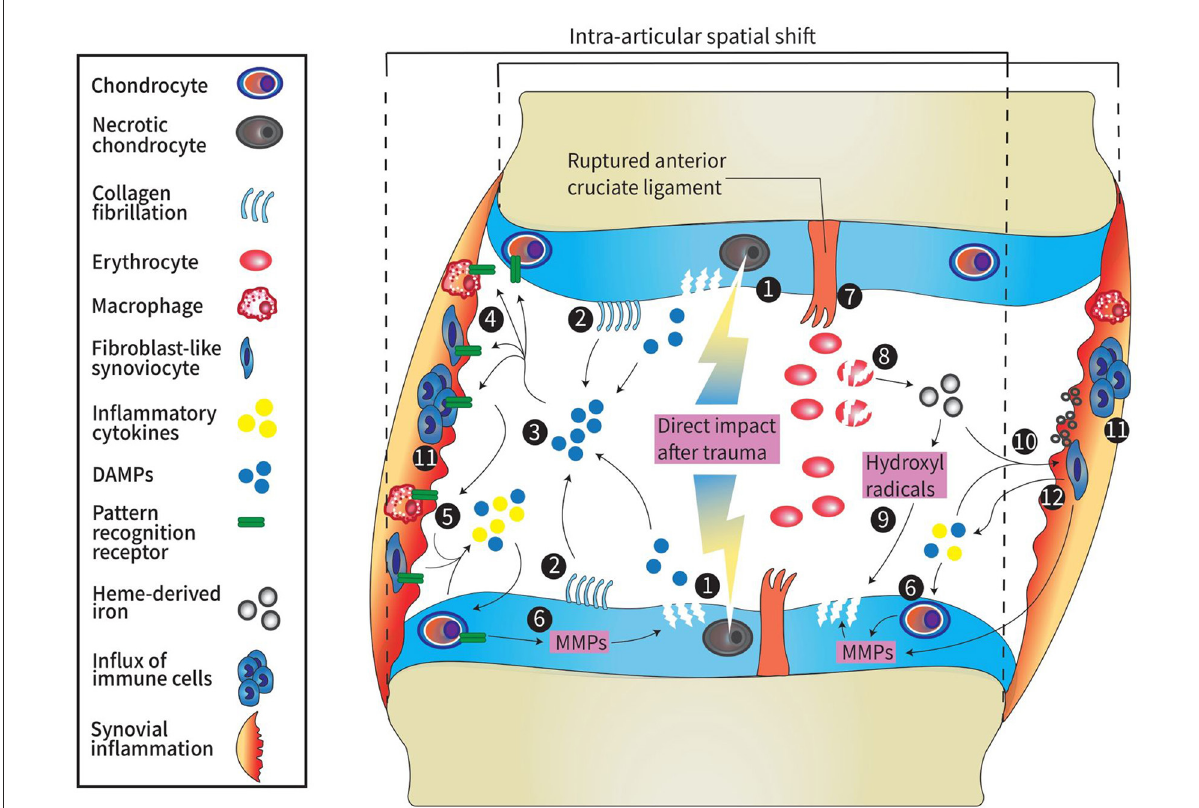
FIGURE1 Schematic overview of pathophysiology in PTOA. 1: Direct impact from trauma higher than 10–20 MPa results in necrotic cell death of chondrocytes and damage to the ECM of the cartilage. 2: A spatial shift due to increased joint laxity after ligament rupture causes a change in load bearing contact area. This leads to fibrillation of the collagen network and when fractured, these fibrils act as DAMPs. 3: DAMPs (e.g., glycoproteins proteoglycans, or GAG) are released into the articular cavity as result of acute traumatic cartilage damage. 4: DAMPs bind to pattern recognition receptors (TLRs, NLRs, and RAGE) on the surface of immune cells, chondrocytes, osteoblasts (not shown here), macrophages and fibroblasts. 5: activated cells release inflammatory cytokines such as IL-1, IL-4, IL-6, IL-8, IL-10, IL-17, TNF- α , chemokines, cathepsins, complement cascade factors, and DAMPs [e.g., S-100 proteins, high-mobility group box protein 1 (HMGB1), or uric acid]. 6: Inflammatory factors promote release of MMPs and ADAMTS by synoviocytes and chondrocytes which leads to cartilage degradation. 7: Major peri-articular tissue damage (e.g., anterior cruciate ligament rupture) causes hemarthrosis. Degradation of erythrocytes causes the release of heme-derived iron molecules. 8: Heme-derived iron molecules react with oxygen metabolites generated by monocytes and macrophages forming hydroxyl radicals. 9: hydroxyl radicals induce chondrocyte apoptosis and therefore promote cartilage damage1. 10: Synovial inflammation is induced by DAMPs, pro-inflammatory factors and hemosiderin deposits in the synovium formed by the accumulation of iron molecules. 11: Synovial inflammation is characterized by influx of immune cells. 12: Cells in the inflamed synovium release cytokines, DAMPs and promote release of MMPs leading to cartilage breakdown which again promotes the release of DAMPs into the joint cavity. MPa, millipascal; ECM, extracellular matrix; DAMP, damage-associated molecular pattern; GAG, glycoproteins and glycosaminoglycans; TLRs, Toll-like receptors; NLRs, NOD-like receptors; RAGE, receptor for advanced glycation end-products; IL, interleukin; MMPs, matrix metalloproteinases; ADAMTS 9, a disintegrin and metalloproteinase with thrombospondin